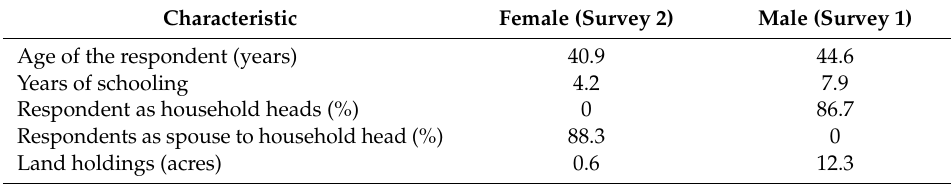
Table 1. Respondents’ profile from the paired households (n = 128).